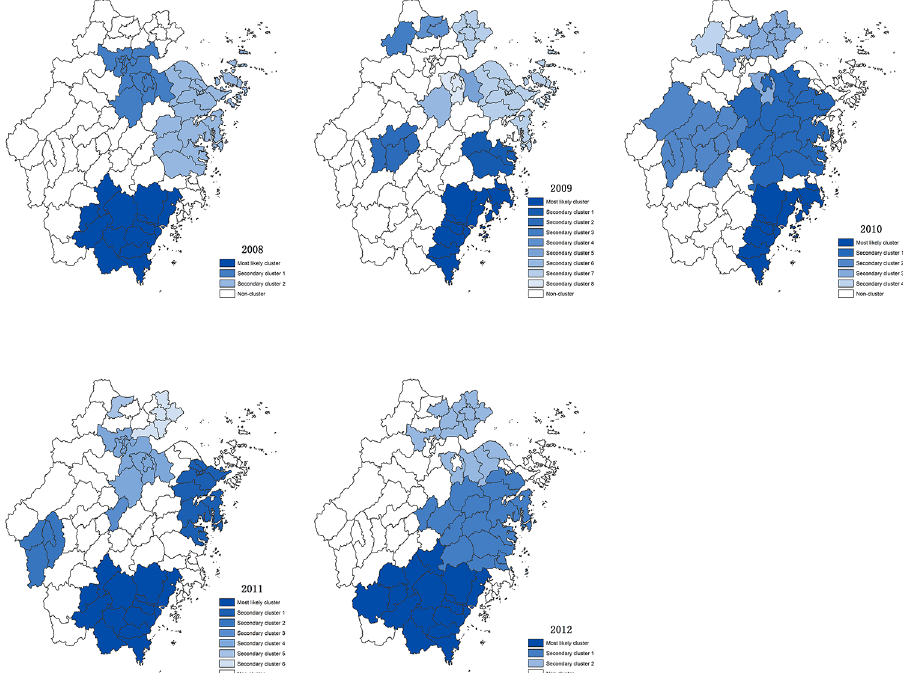
Fig 6. The results of space-time cluster analysis for mild cases of Zhejiang Province, 2008 –